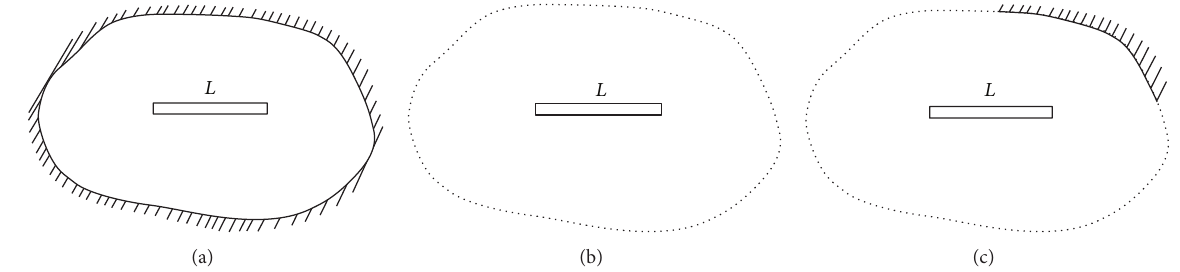
Figure 3: Horizontal wells with different boundaries ((a) closed boundary; (b) constant pressure boundary; (c) mixed